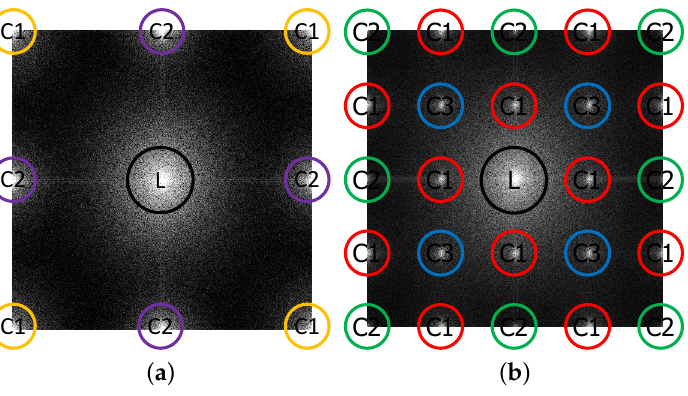
Figure 2. ( a ) Frequency analysis of Bayer pattern CFA, ( b ) Frequency analysis of Canon-RGBW